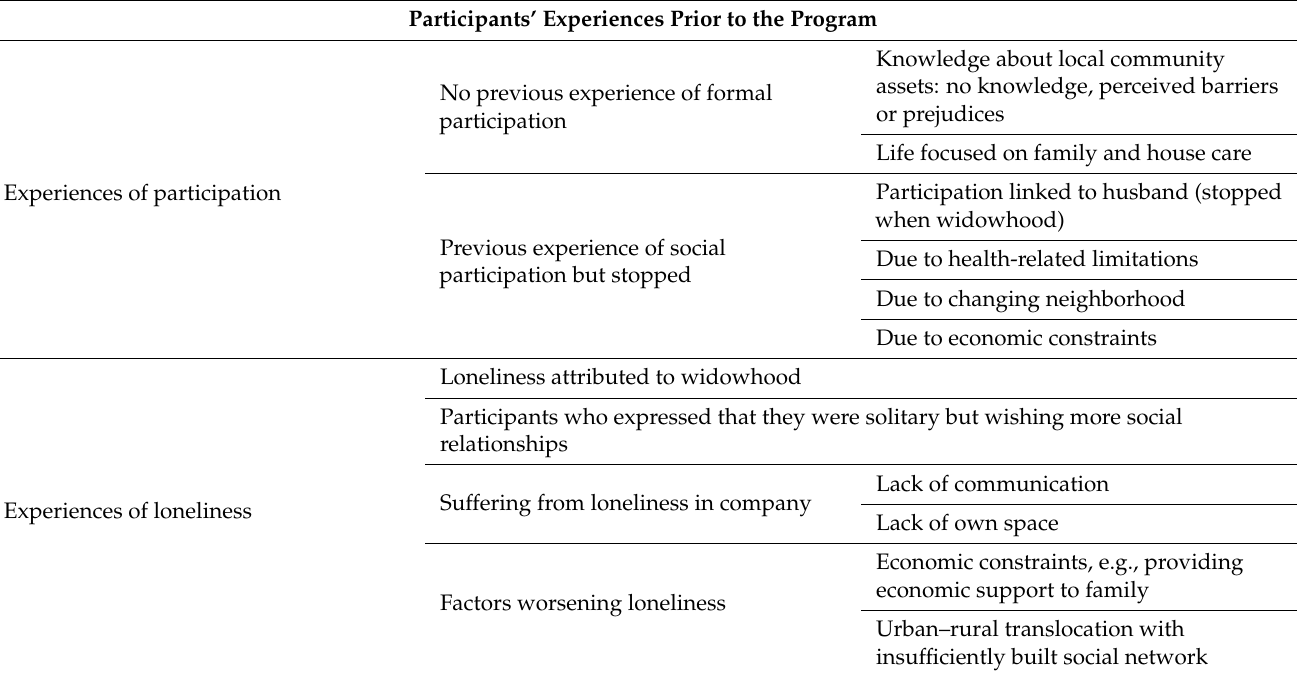
Table 2. Summary of results regarding participants’ experiences prior to the